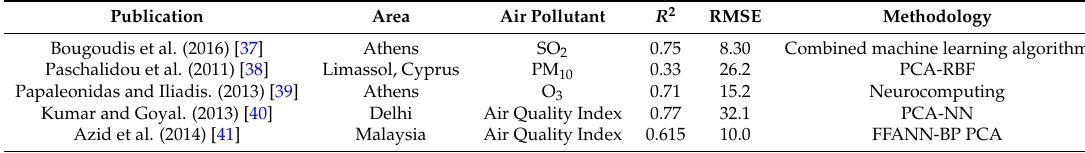
Table 5. The mean performance of other similar methods. RMSE: root mean square error; R 2 : coefficient of